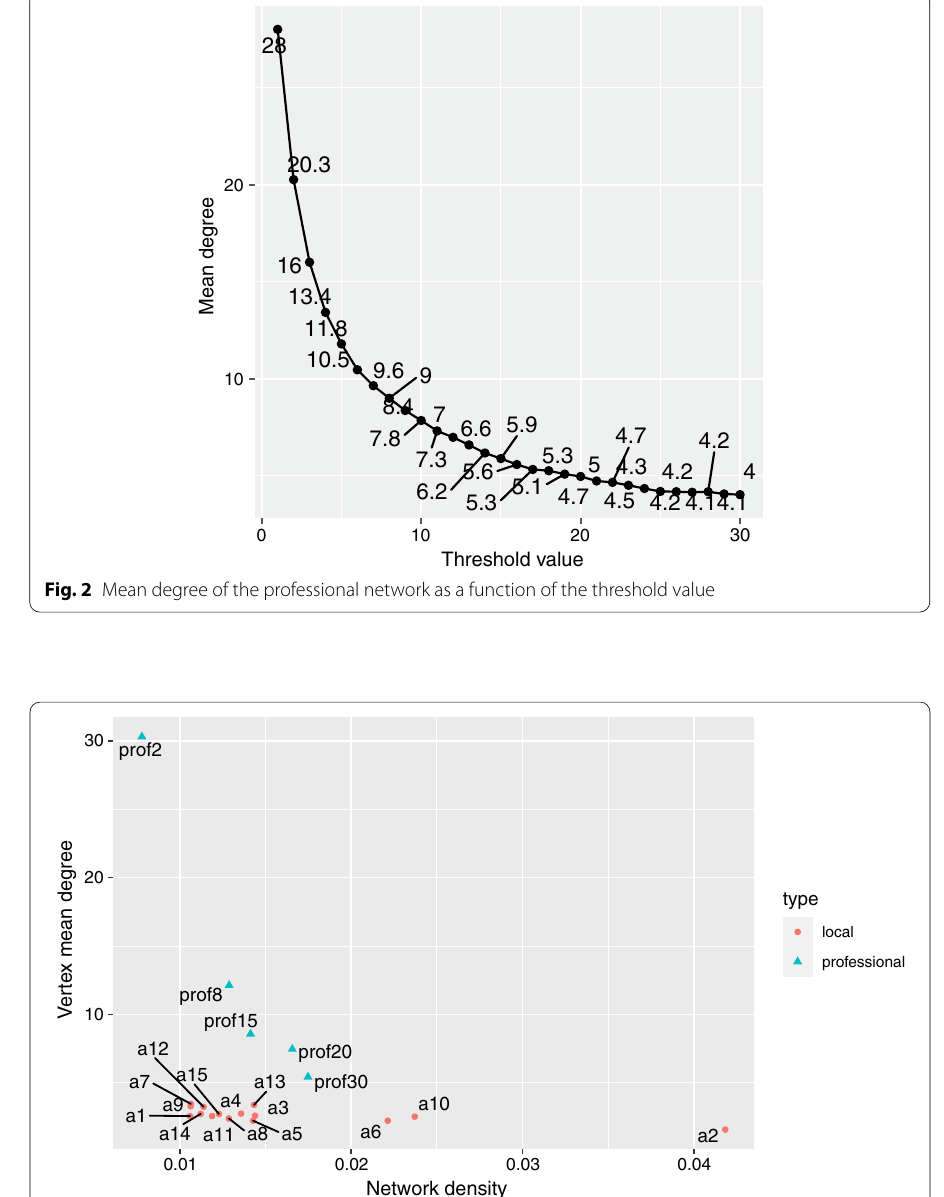
Fig. 3 Summary on professional and local networks. Numbers in professional networks indicate the threshold value used to produce the